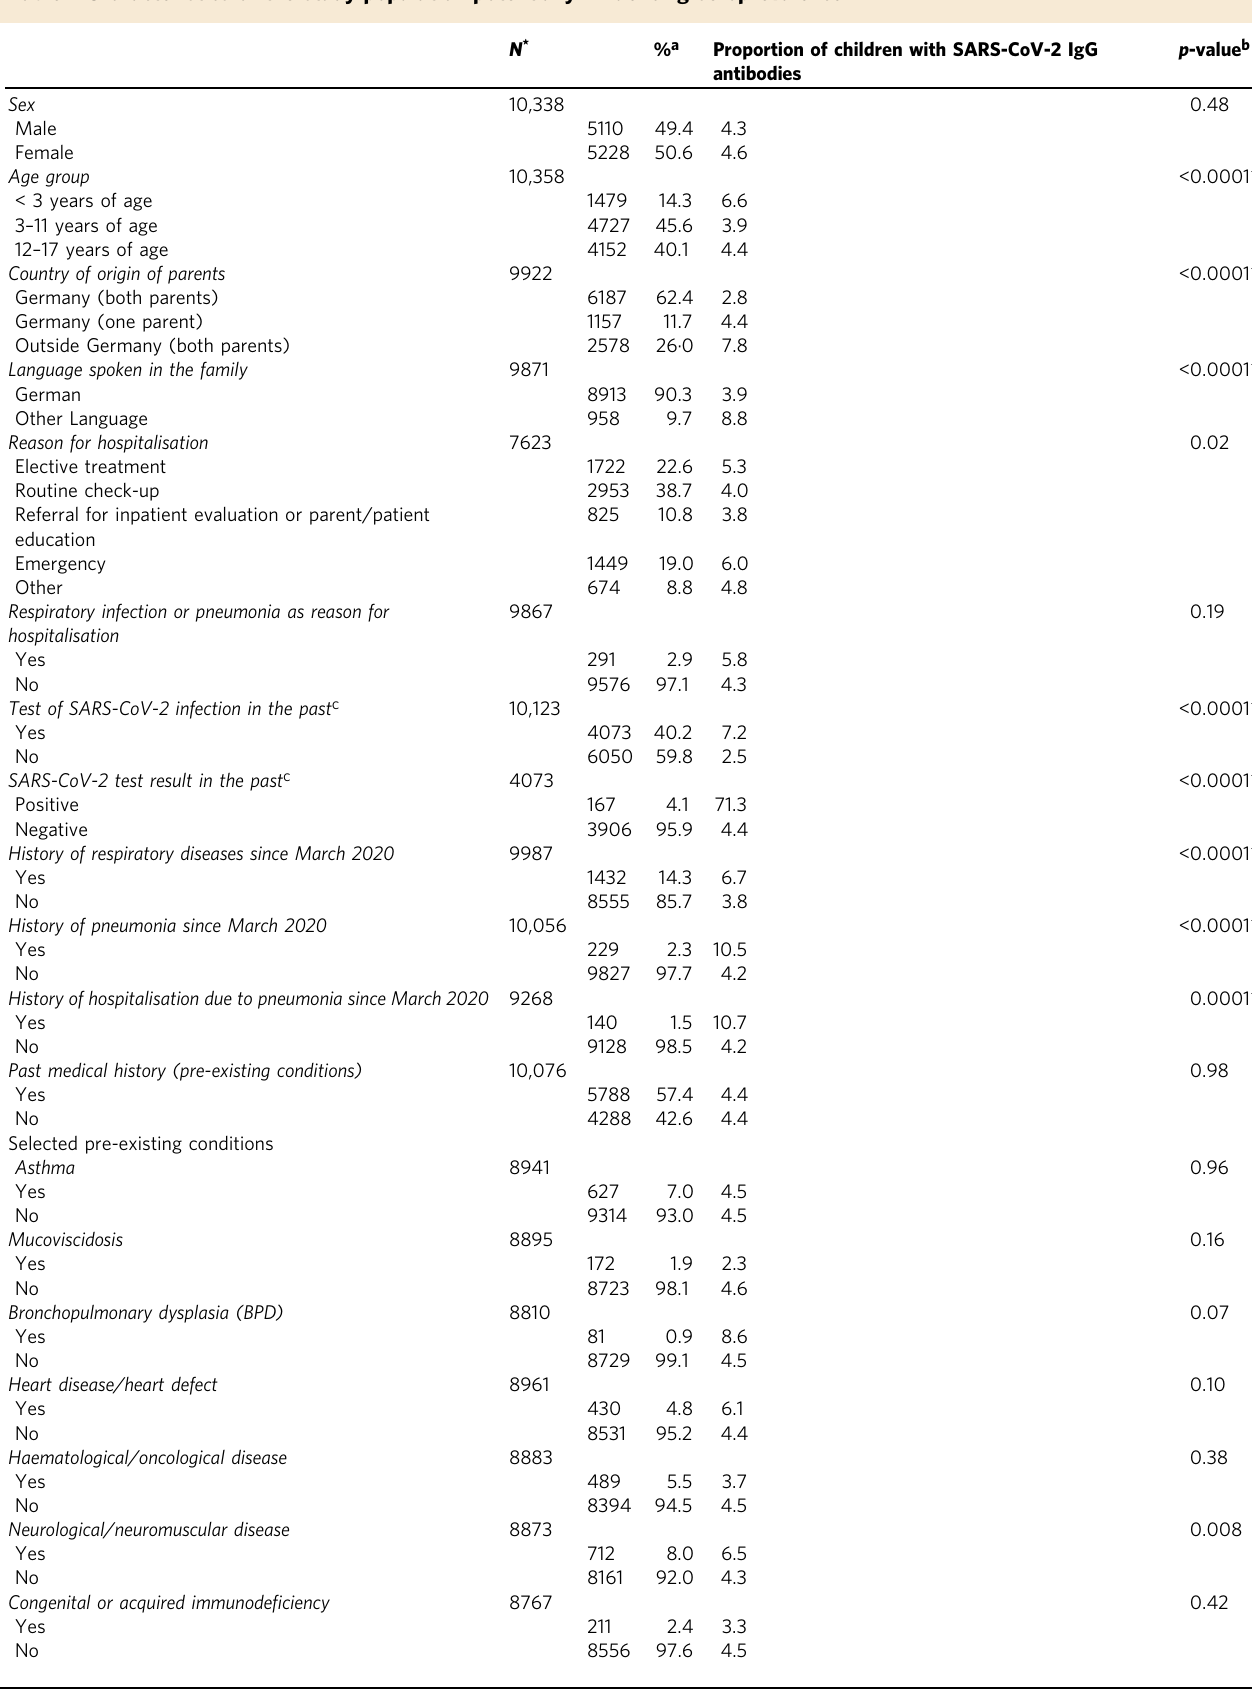
Table 1 Characteristics of the study population potentially in fl uencing seroprevalence.